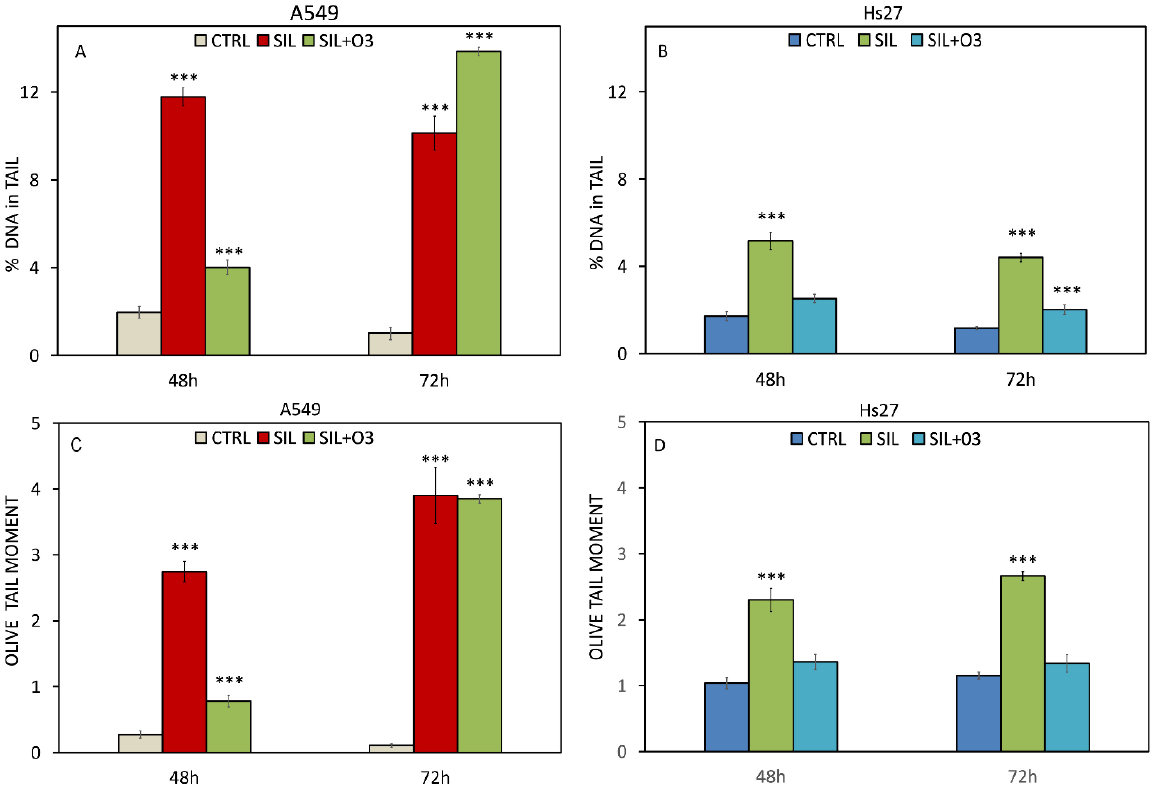
Figure 5. Genotoxic effect of silica and combined silica with O 3 (120 ppb) on cell lines A549 and HS27 at 24 h and 48 h. In panel ( A , B ) the damage is reported, expressed as percentage DNA present in tail in A549 and HS27, respectively; in panel ( C , D ) olive tail moment in A549 and HS27 is reported, respectively. H 2 O 2 150 µM was used as positive control. Significance values were determined according to the Student t -test: *** = p < 0.0005. All treated were compared to their respective controls. Error bars are the standard error of the mean.